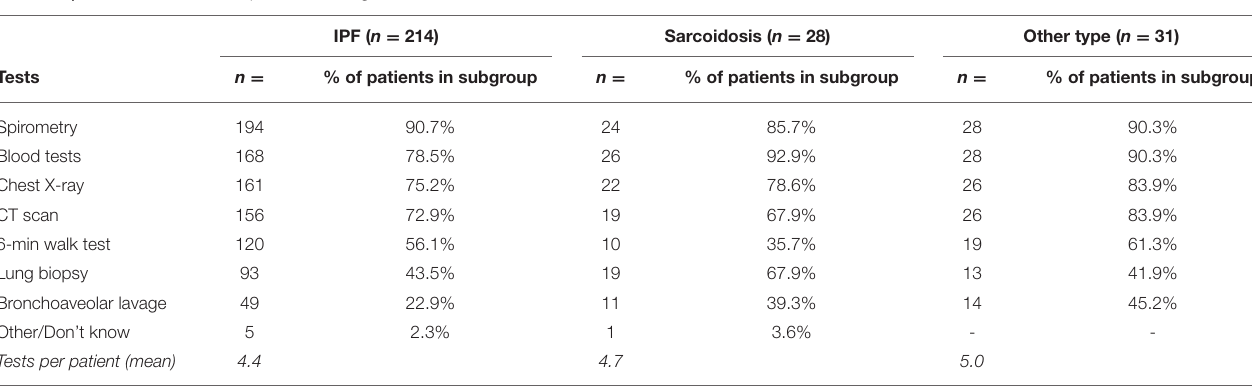
TABLE 1 | Performed tests in hospital before